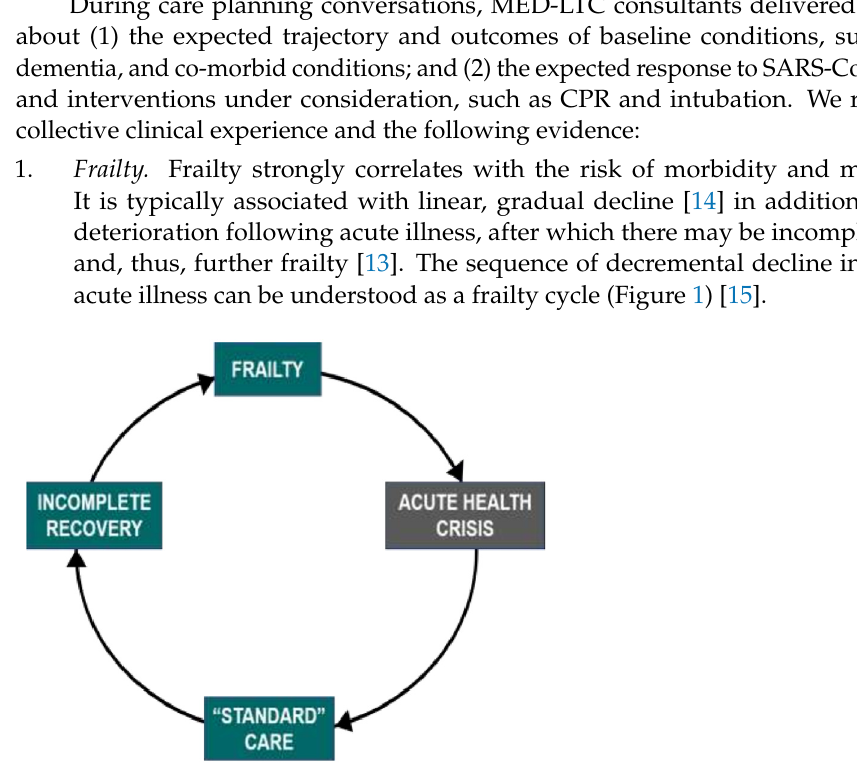
Figure 1. The frailty